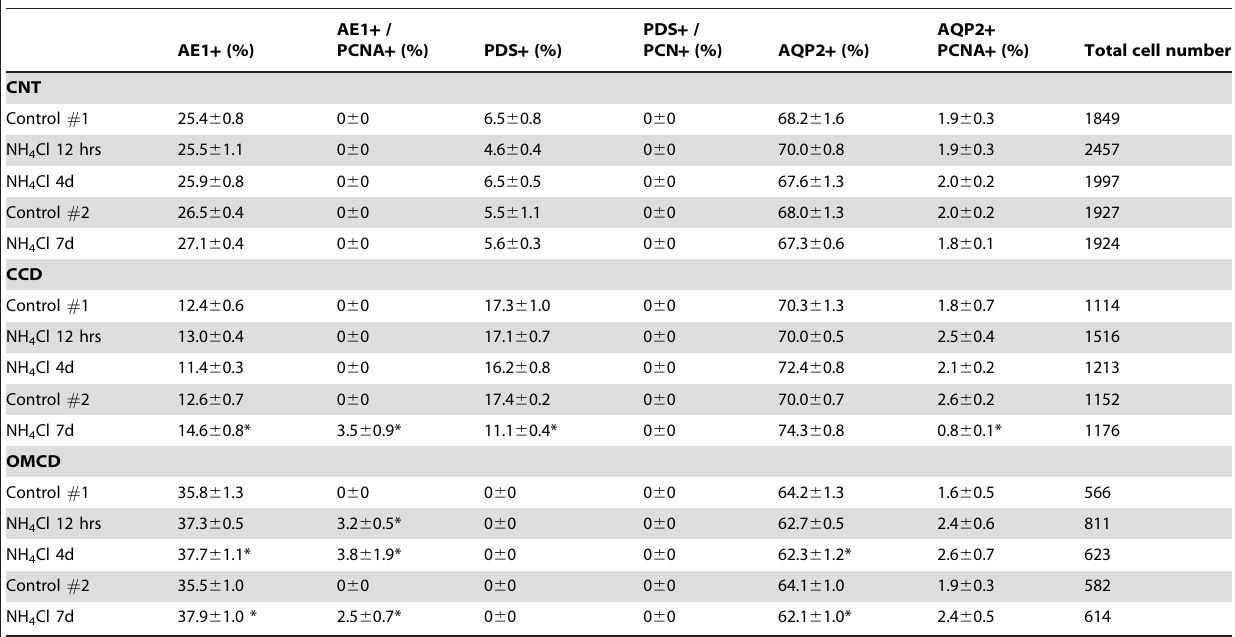
Table 2. PCNA labeled cells.